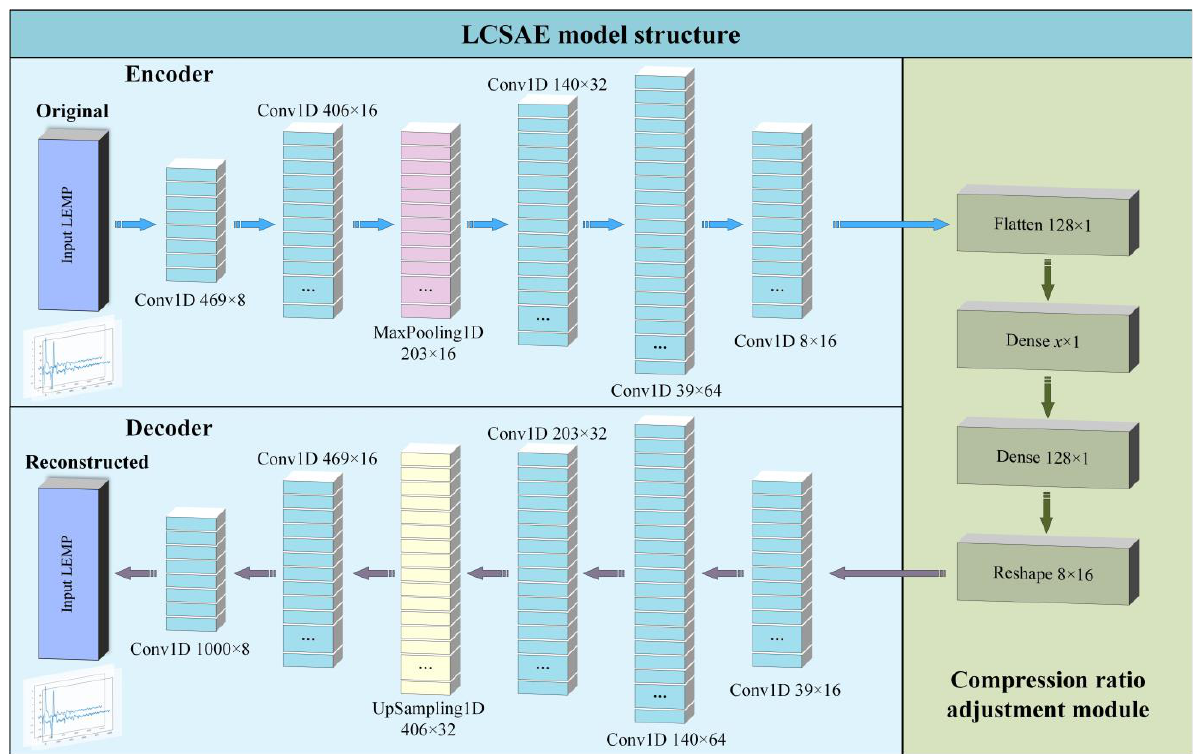
Figure 6. The block representation of the proposed LCSAE model for LEMP compression. Table 1. Detailed parameters of LCSAE model structure.